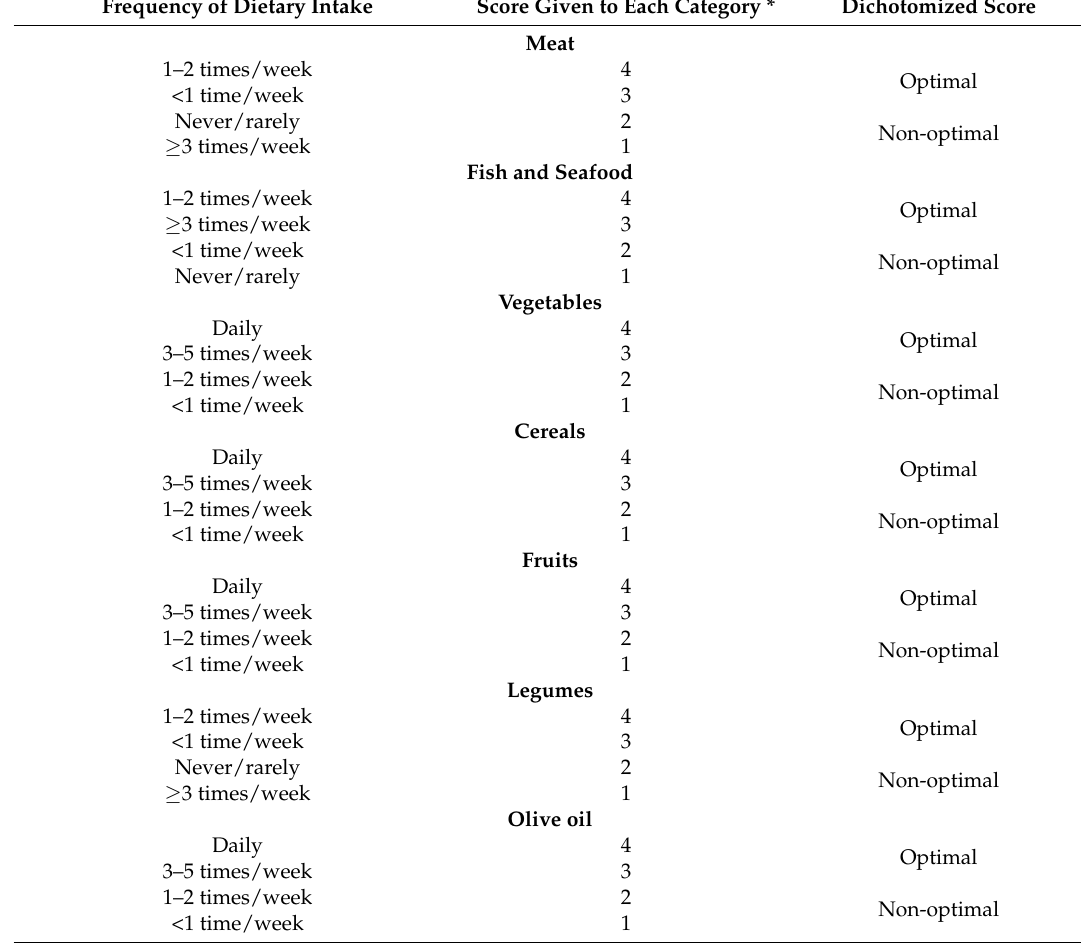
Table 1. Dichotomization of the frequency of dietary